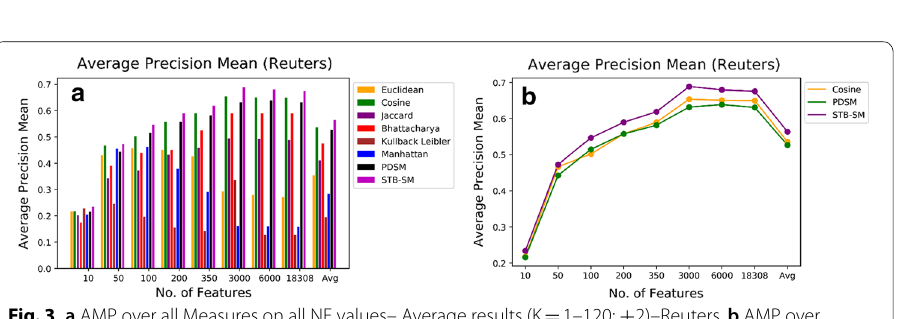
1–120; 2)–Reuters. b AMP over = + 1–120; = +